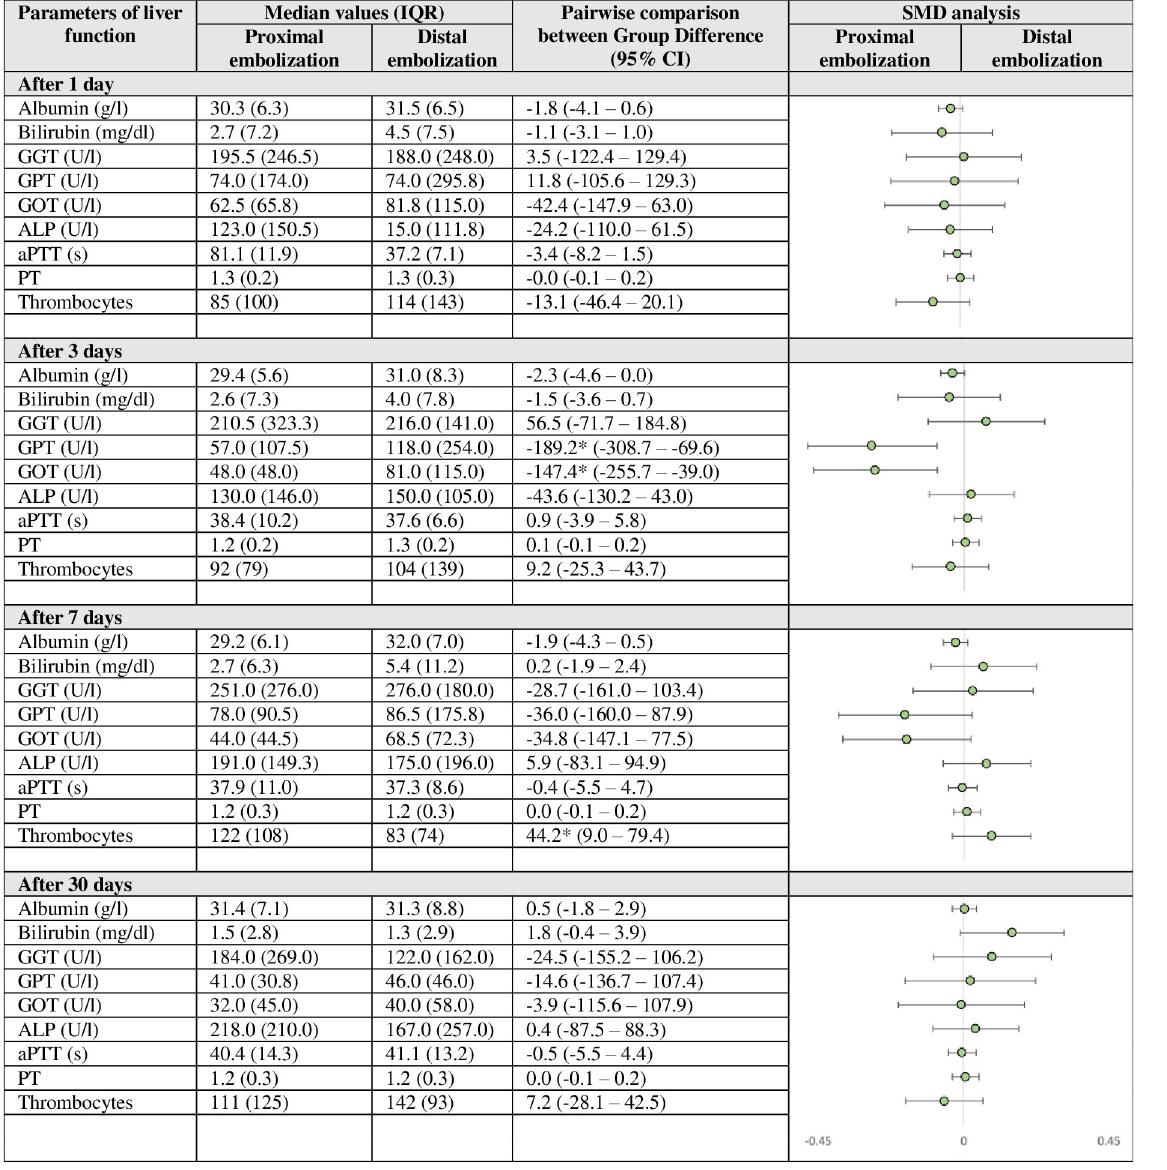
Fig 4. Median values as well as pairwise comparisons differentiated after location of embolization of the SA. � The mean difference is significant at the .05 level. IQR, interquartile range; SA, splenic artery; CI, confidence interval; GGT, gamma-glutamyl transferase, GPT, glutamic-pyruvic transaminase; GOT, glutamic-oxaloacetic transaminase; ALP, Alkaline Phosphatase; PT, Prothrombin Time. Forest plot analysis of the log-transformed standardized mean difference (SMD) for pairwise comparison.